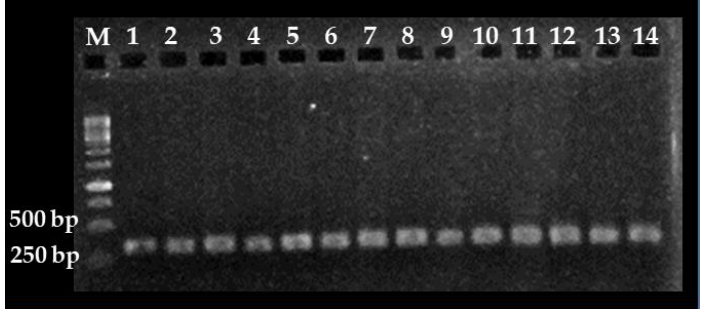
Figure 1. Cyclospora cayetanensis 18S rRNA DNA fragments obtained with the nested PCR assays. Lanes 1 to 14: DNA (3 ng) extracted from C. cayetanensis oocyst. M: molecular weight marker.